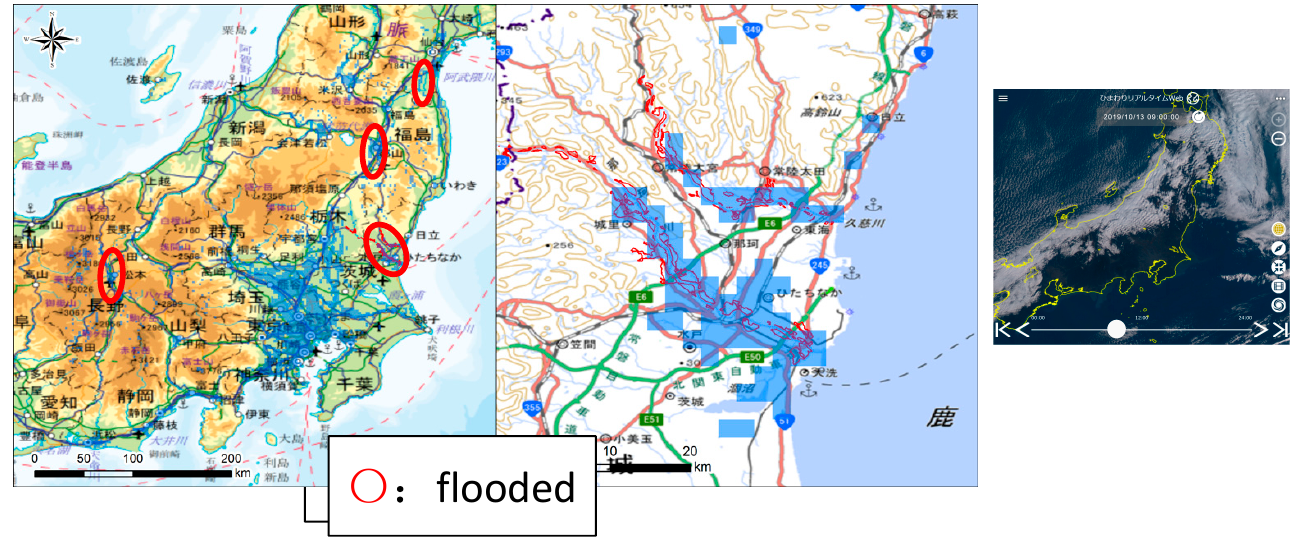
Figure 2. Geographical map of the flooded area (blue-colored area) detected by Himawari-8 AHI at 09:00 JST on 13 October 2020. The background maps are under copyright by Geospatial Information Authority of Japan. National Institute of Information and Communications Technology (NICT) Himawari real-time web true-color red, green, and blue (RGB) image at the same time also shown in the right panel.